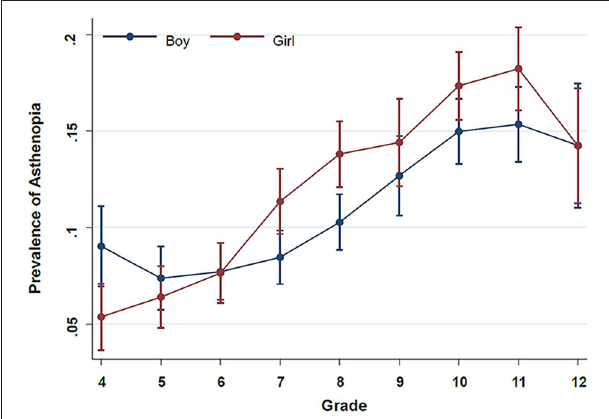
FIGURE 1 | Prevalence of asthenopia with 95% confidence interval across grade stratified by gender. The prevalence of asthenopia was estimated from a marginal logistic regression model using the total screen time as the exposure and with the adjustment for the grade, gender, grade*gender, administrative district (city, county, town, or countryside), physical activity (active vs. not active), and sleep time ( < 8, 8–9.9, ≥ 10h), myopia (yes vs. no), astigmatism (yes vs. no), and glasses-wearing status (never, occasionally, or always), lying down or lying on the stomach while watching a screen (never, occasionally, often, or always), distance from eyes to screen ( ≤ 33, 34–65, or ≥ 66cm), rest time between classes, eye exercise (0, 1–4, 5–6, or ≥ 7 times/week), and eye drops for foreign body sensation, dry or fatigue eyes (0, 1, 2, or ≥ 3